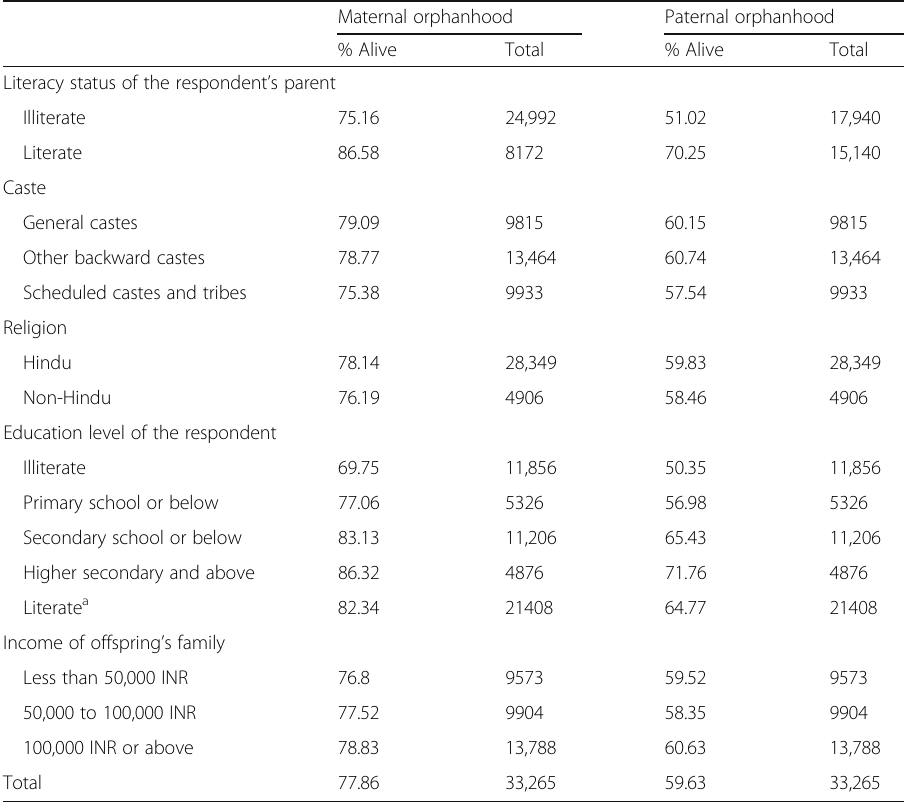
Table 2 Percentage of ever-married women aged 15 – 49 with mother/father living by socioeconomic status, India Human Development Survey, 2011 –